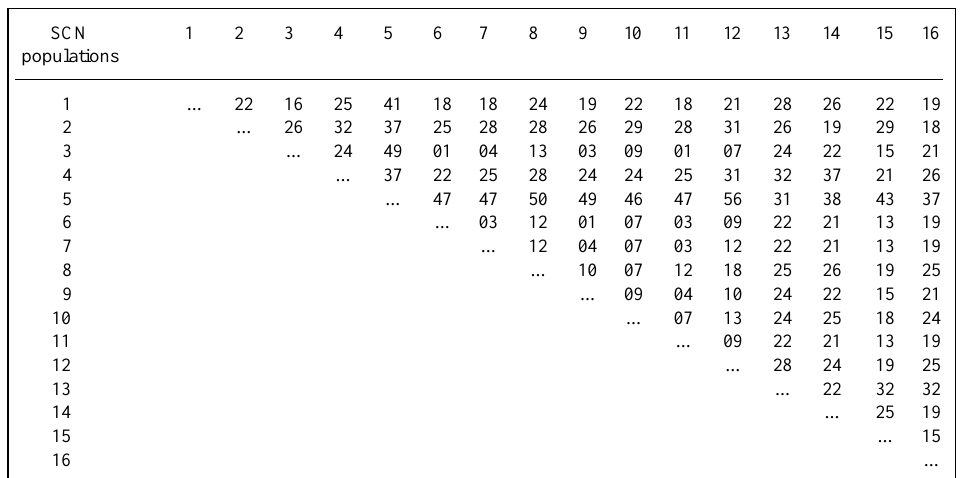
Table III - Pairwise genetic distances as percent disagreement among 16 populations of Heterodera glycines used in this study.